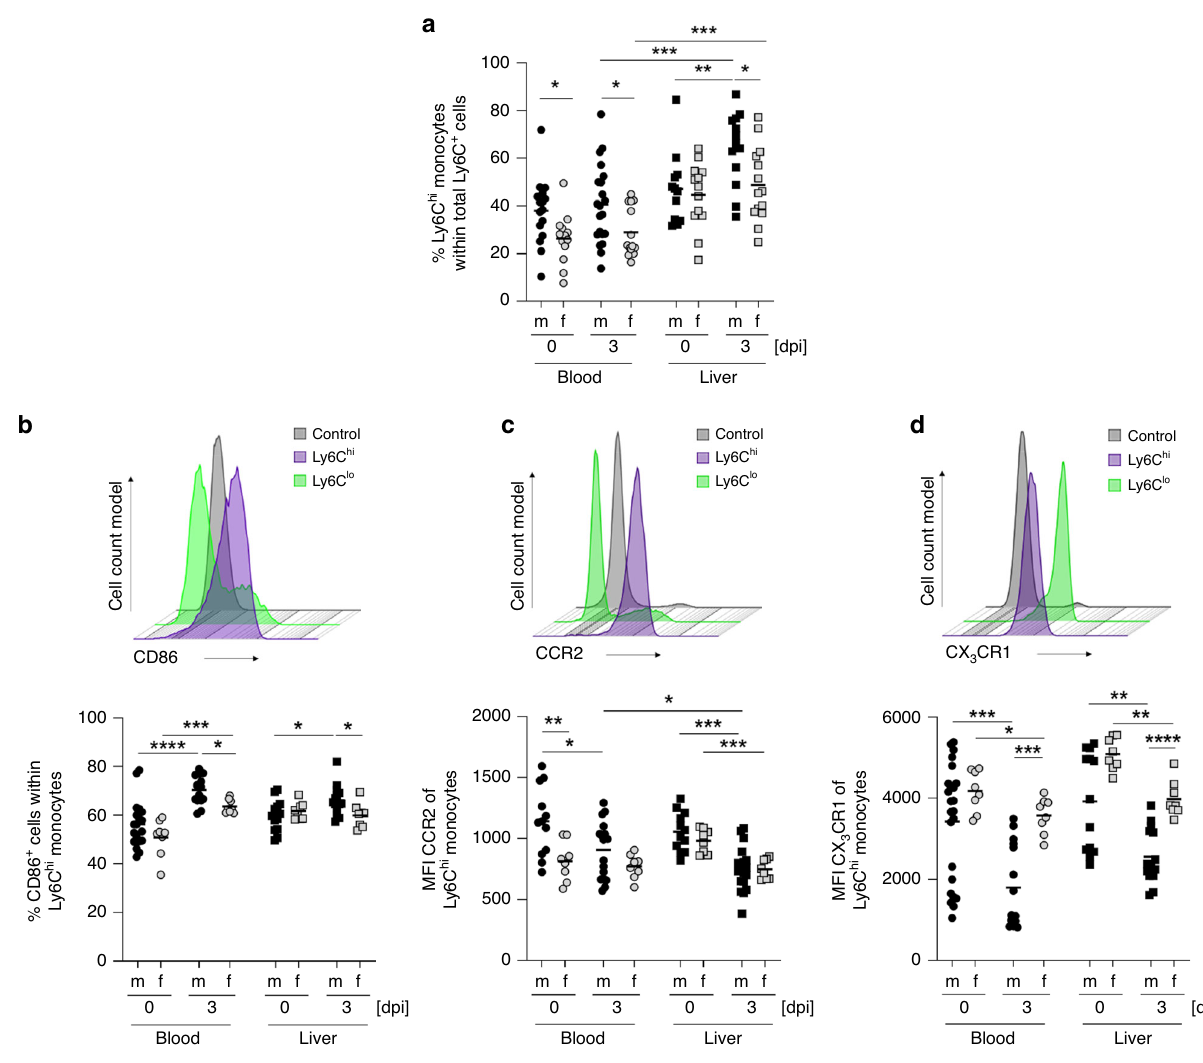
Fig. 2 Male mice show higher percentages of classical monocytes upon infection. a Percentage of Ly6C hi monocytes within the total Ly6C + monocyte population of CD11b + cells isolated from the blood and liver of naïve and E. histolytica (Day 3 p.i.) - infected mice (blood: n m/f d0 = 16/13; n m/f d3 = 21/14; liver: n m/f d0 = 12/13; n m/f d3 = 13/14; pooled data of four independent experiments; depicted are the means). Histogram and percentage of b CD86 + cells, and the c MFI of CCR2 and d CX 3 CR1 of Ly6C hi monocytes in the blood and the liver of naïve and E. histolytica -infected mice (Day 3 p.i.), as determined by fl ow cytometry ( b blood: n = 19/8; n = 15/8; liver: n = 13/8; n = 15/8; c blood: n = 12/8; n = 17/8; liver: n = 12/8; m/f d0 m/f d3 m/f d0 m/f d3 m/f d0 m/f d3 m/f d0 = 17/8; d blood: n = 24/8; n = 15/8; liver: n = 13/8; n = 15/8; pooled data of two independent experiments; depicted are the n m/f d3 m/f d0 m/f d3 m/f d0 m/f d3 means). P -values were calculated using two-tailed grouped analysis Mann – Whitney test ( a – d ), * P < 0.05; ** P < 0.01; *** P < 0.001; **** P < 0.0001). Source data are provided as a Source Data fi